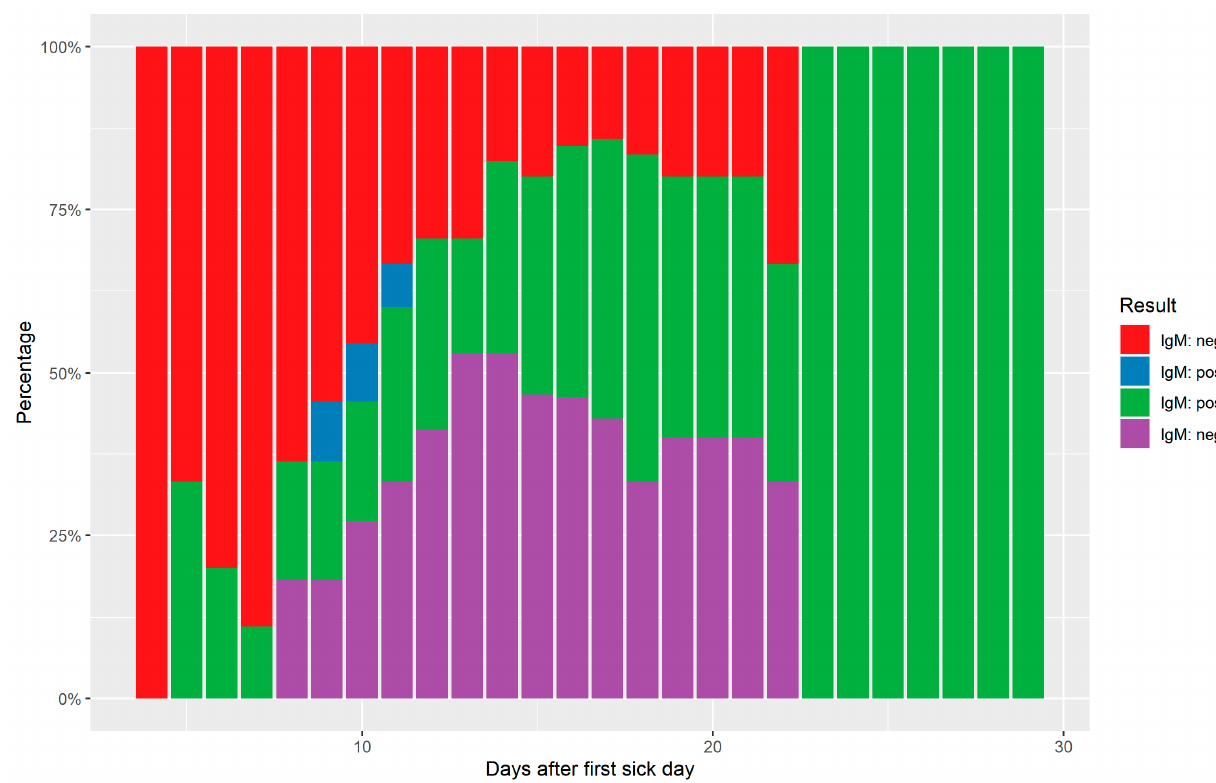
Figure 1. Individual sequential serological results of the Biozek COVID-19 test.